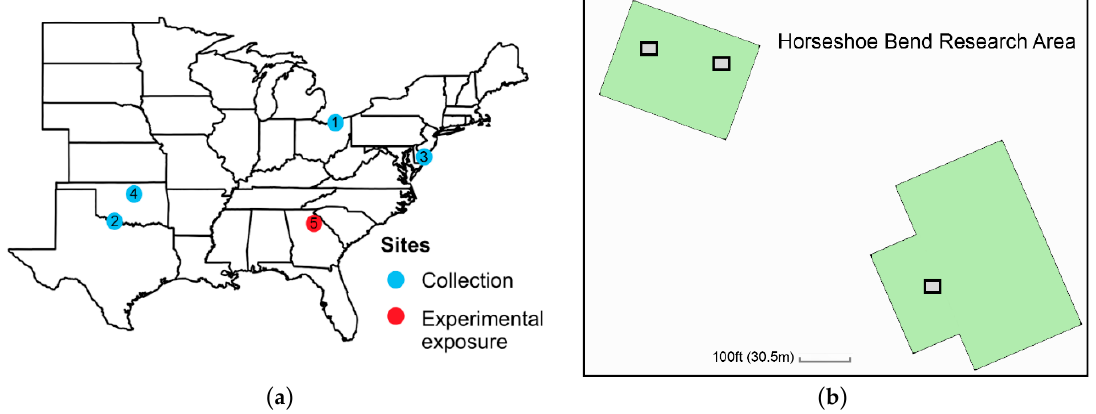
Figure 1. Map of eastern United States with collection sites and experimental exposure site along with schematic of the exposure site. ( a ) Migratory monarchs were captured at four stopover sites (blue symbols). Capture locations included (1) Cleveland, OH, USA ( n = 123 monarchs) on 17 September 2015; (2) Burkburnett, TX, USA ( n = 102) on 3 October 2015; (3) Cape May, NJ, USA ( n = 168) on 12 October 2015; and (4) Stillwater, OK, USA ( n = 106) on 13 October 2015. Experimental exposure to milkweed treatments in outdoor cages took place in Athens, GA (5; red symbol) at the ( b ) Horseshoe Bend Research Area of the University of Georgia. The research area includes pen grassy areas (green) along with three positions where cages were setup (gray boxes). Each cage held about 30 adults with 50:50 sex ratio.